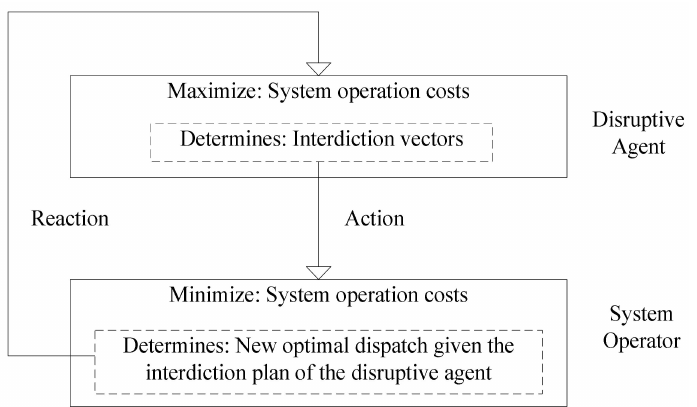
Figure 1. Bi-level programming